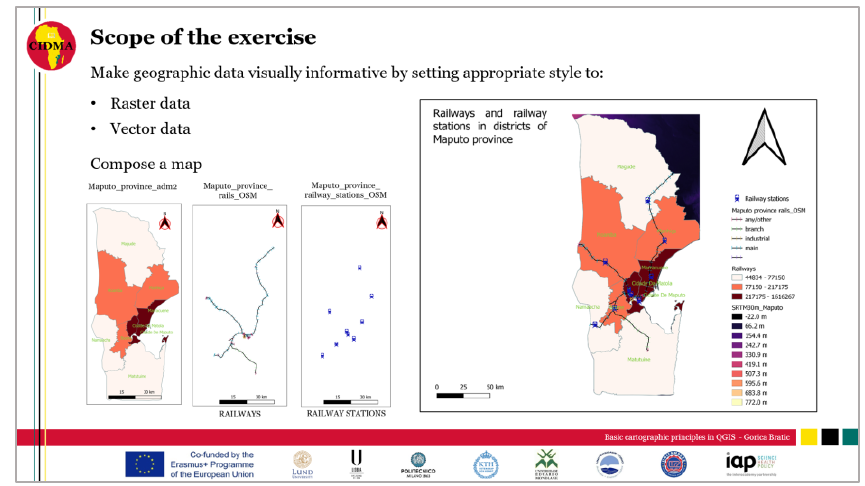
Figure 4. Example from a practical activity to compose a